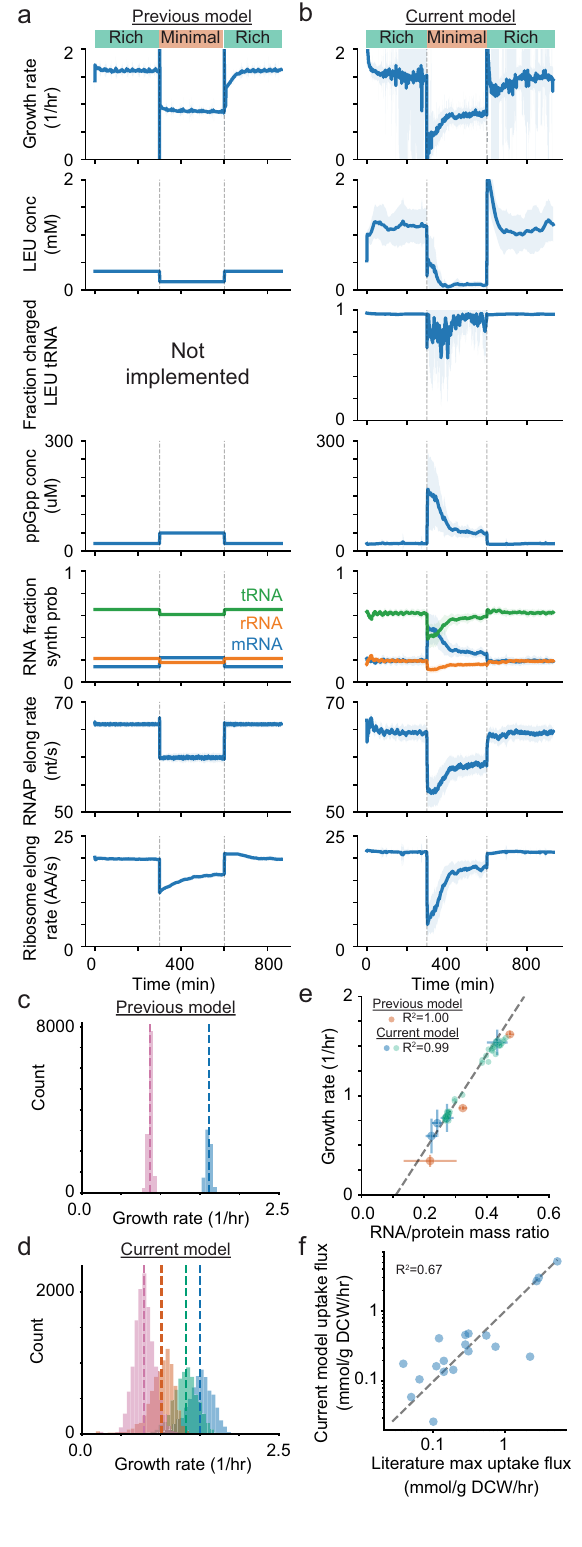
stochastic and dynamic internal state of the simulated cell. Speci fi cally, amino acid concentrations now vary over time in response to a variety of factors instead of being constrained to a fi xed concentration target (leucine is used as a representative example in Fig. 2a, b). Additionally, charged tRNA concentrations